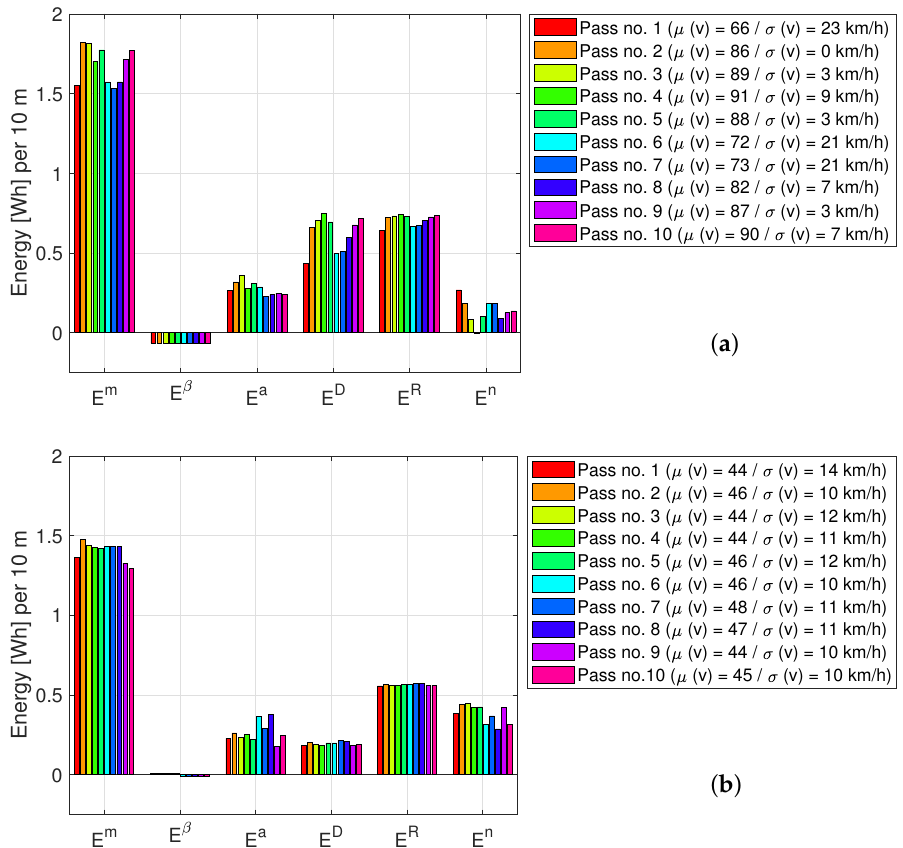
Figure 14. Bar plot of energy consumption data split into car passes and energy components: ( a ) highway road M3 and ( b ) urban ring road O2. Each car pass is shown as a single bar with a different